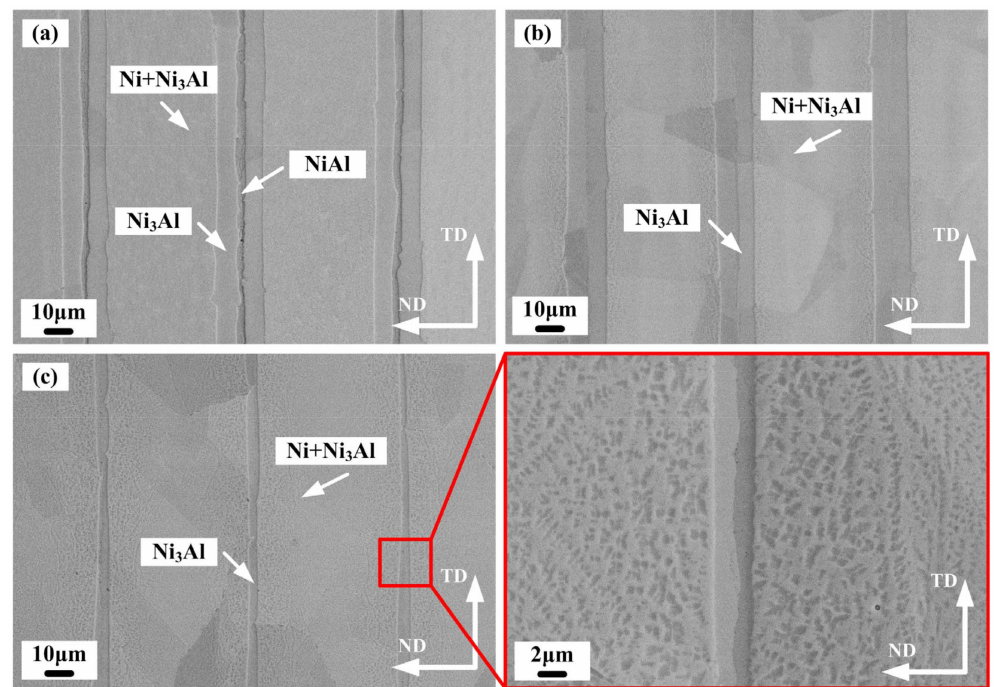
Figure 5. BSE images of the laminated composites: ( a ) N4; ( b ) N5; ( c )